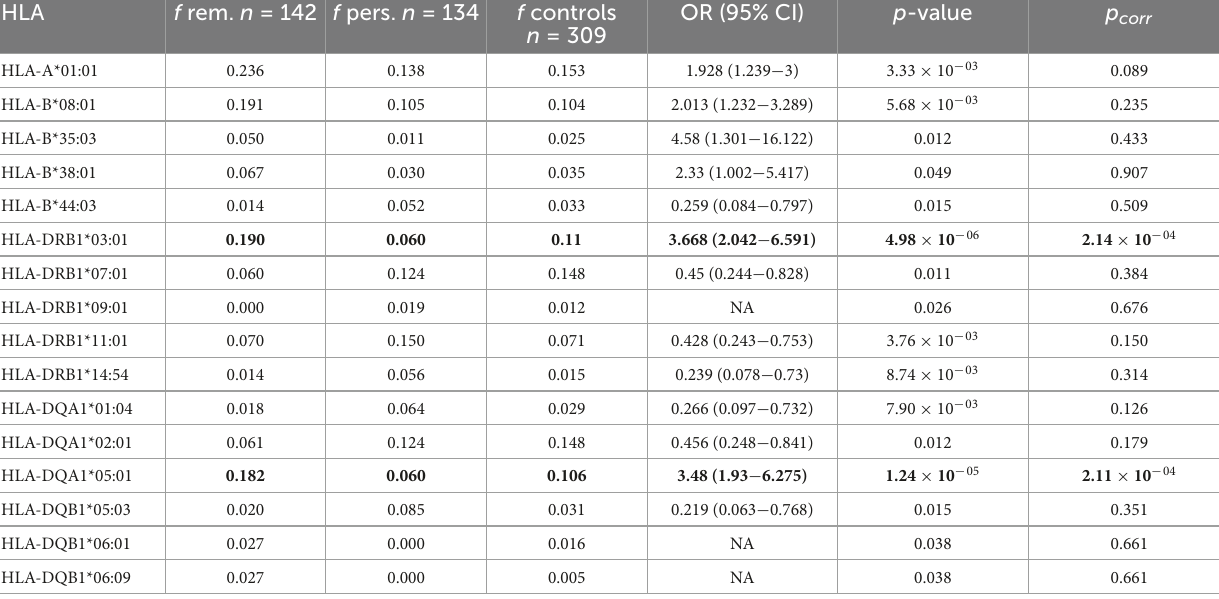
TABLE 5 Comparison of the HLA allele frequencies between the patients with disease remission ( n = 142) compared with the patients with persistent disease course ( n = 134); only the alleles associated at least on the primary level are shown. HLA f rem. n = 142 f pers. n = 134 f controls OR (95% CI) n = 309